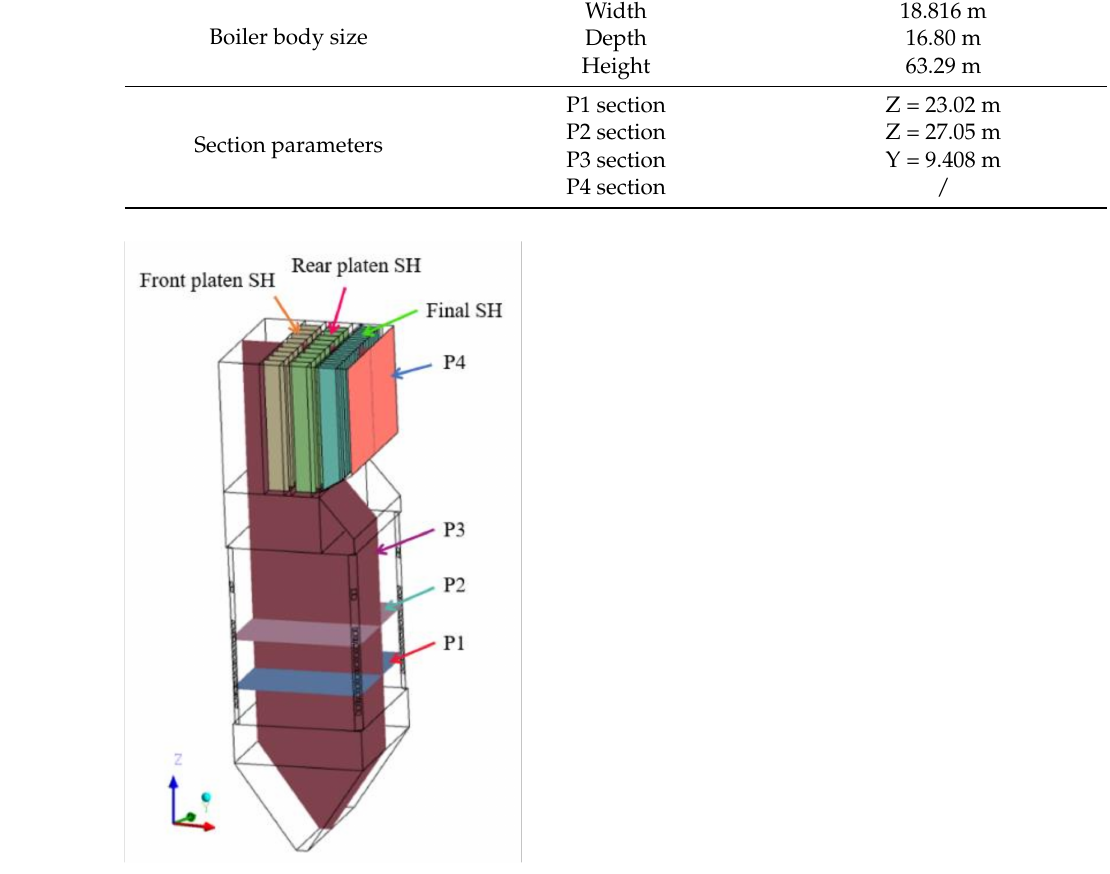
Figure 1. Boiler structure.